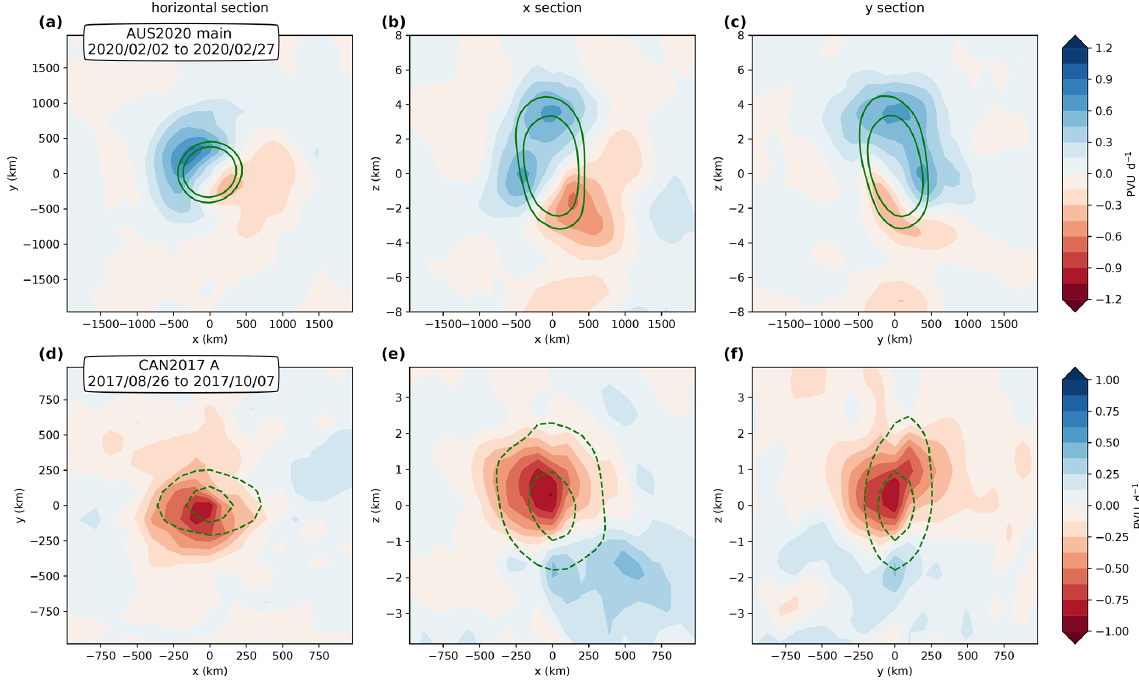
Figure 10. Same as Fig. 8 but for Lait PV